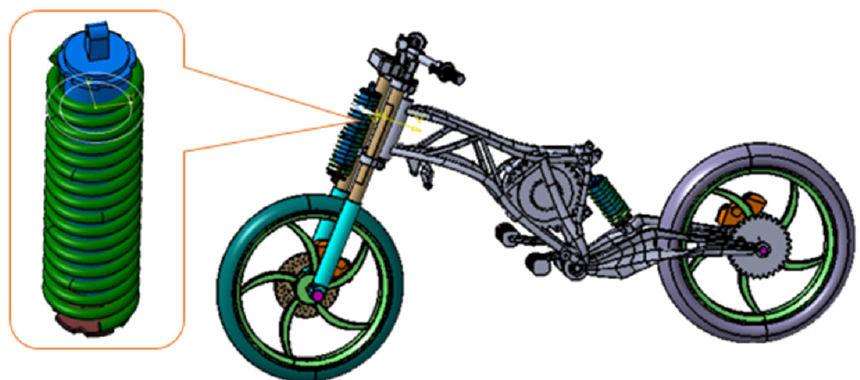
Figure 1. Conventional shock absorbers on a motorcycle.